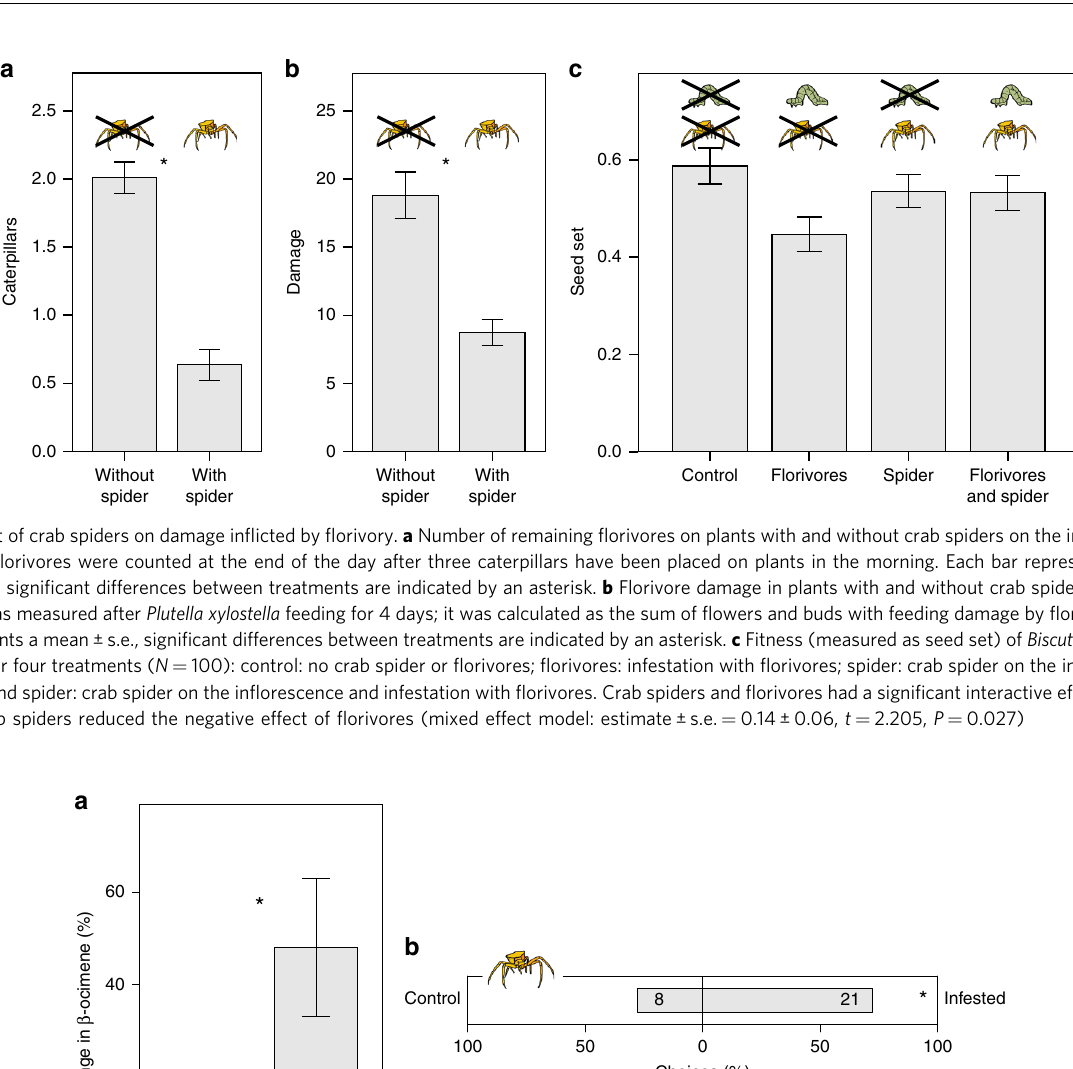
crab spider presence in a plot experiment to measure the fi tness effects of crab spiders and fl orivores separately and in combina- tion. Additionally we monitored the catches of crab spiders. We found that 89.9% of the recorded captures by the crab spiders